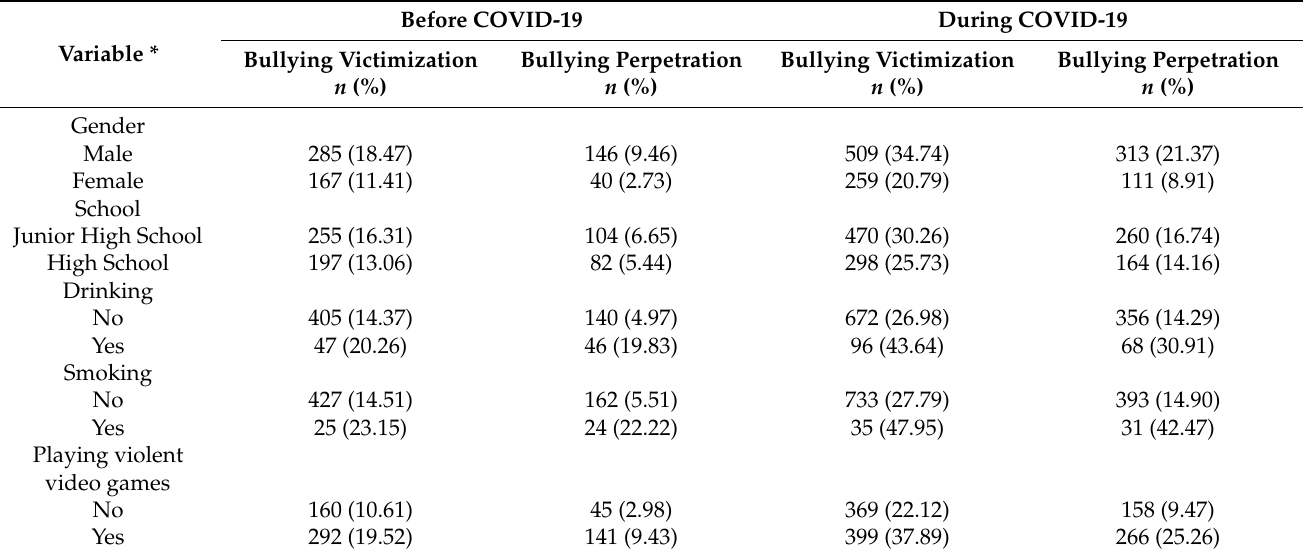
values for smoking; 1.16% missing values for playing violent video games.